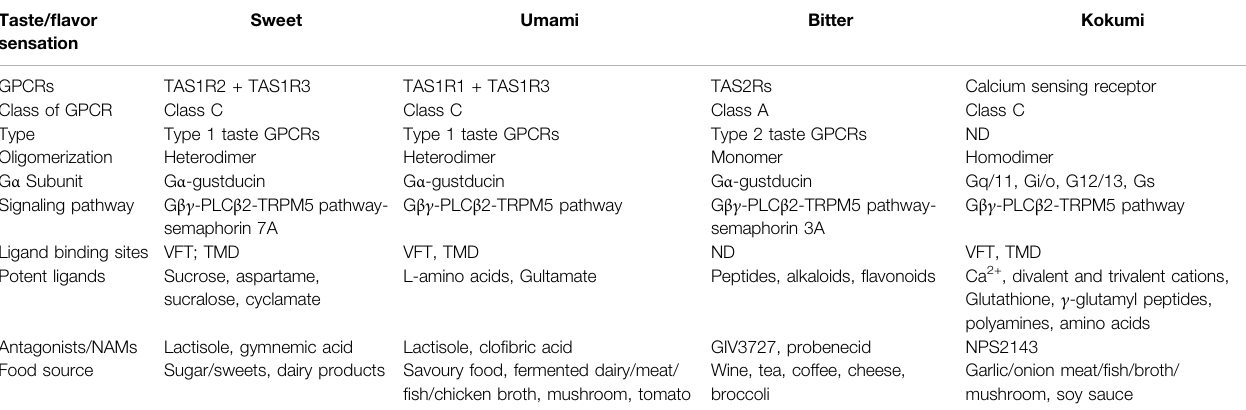
TABLE 1 | Taste GPCRs classi fi cation and their downstream signaling